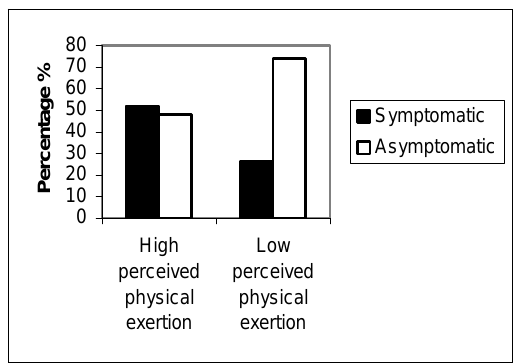
FIGURE 1. Distribution of participants according to perceived physical exertion of the neck and upper limbs and research groups (symptomatic and